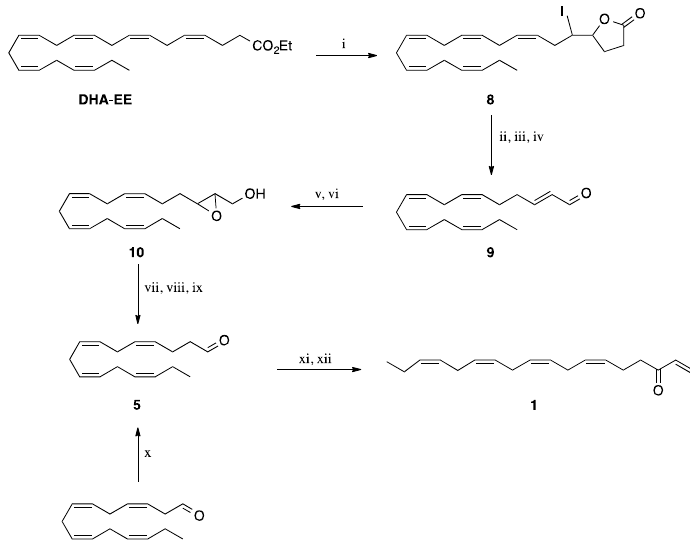
Scheme 3. Alternative synthesis of 1 starting with